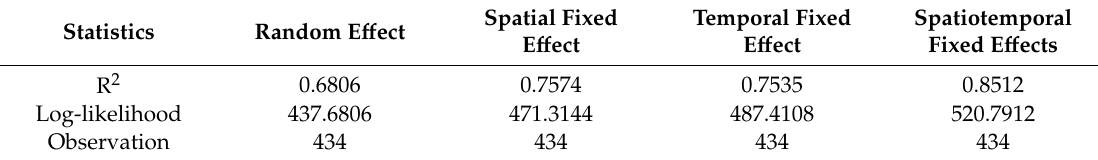
Table 5. Estimation Results of Fixed E ff ect by Spatial Durbin Model